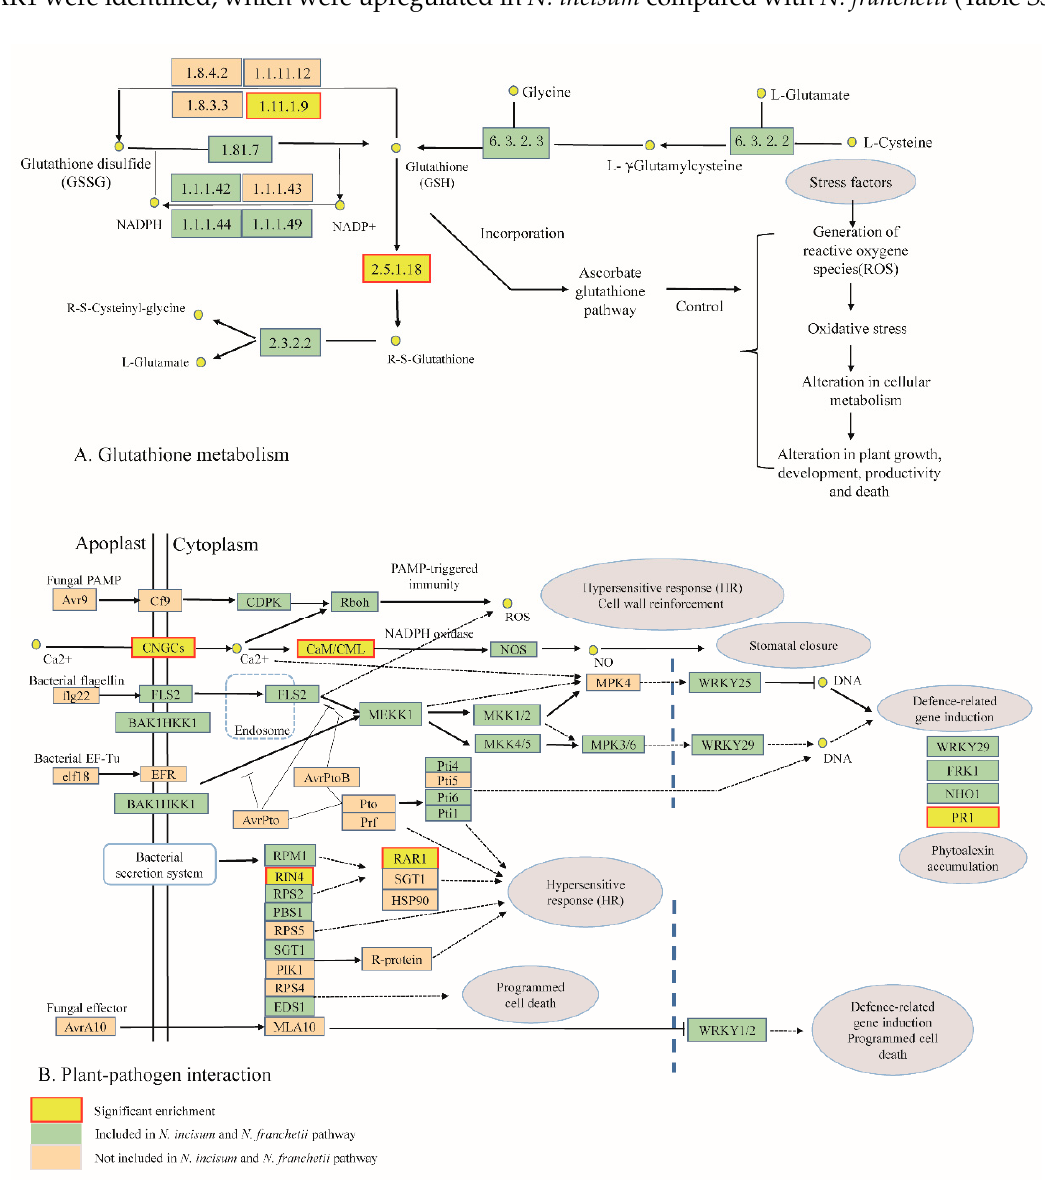
Figure 4. The glutathione-to-glutamate pathway and the plant–pathogen interaction pathway was adapted from the Kyoto Encyclopedia of Genes and Genomes (KEGG) pathway available online (http://www.genome.jp/kegg/pathway.html) [28]. ( A ) Many genes identified by KEGG as encoding the glutathione S-transferase (EC.2.5.1.18) and glutathione peroxidase (EC:1.11.1.9) are enriched in Notopterygium incisum and Notopterygium franchetii ; ( B ) Many genes identified by KEGG as encoding the cyclic nucleotide gated channel (CNGC); CML (CaM/CML), calcium-binding protein, and pathogenesis-related protein 1 (PR1) are enriched in Notopterygium incisum and Notopterygium franchetii .